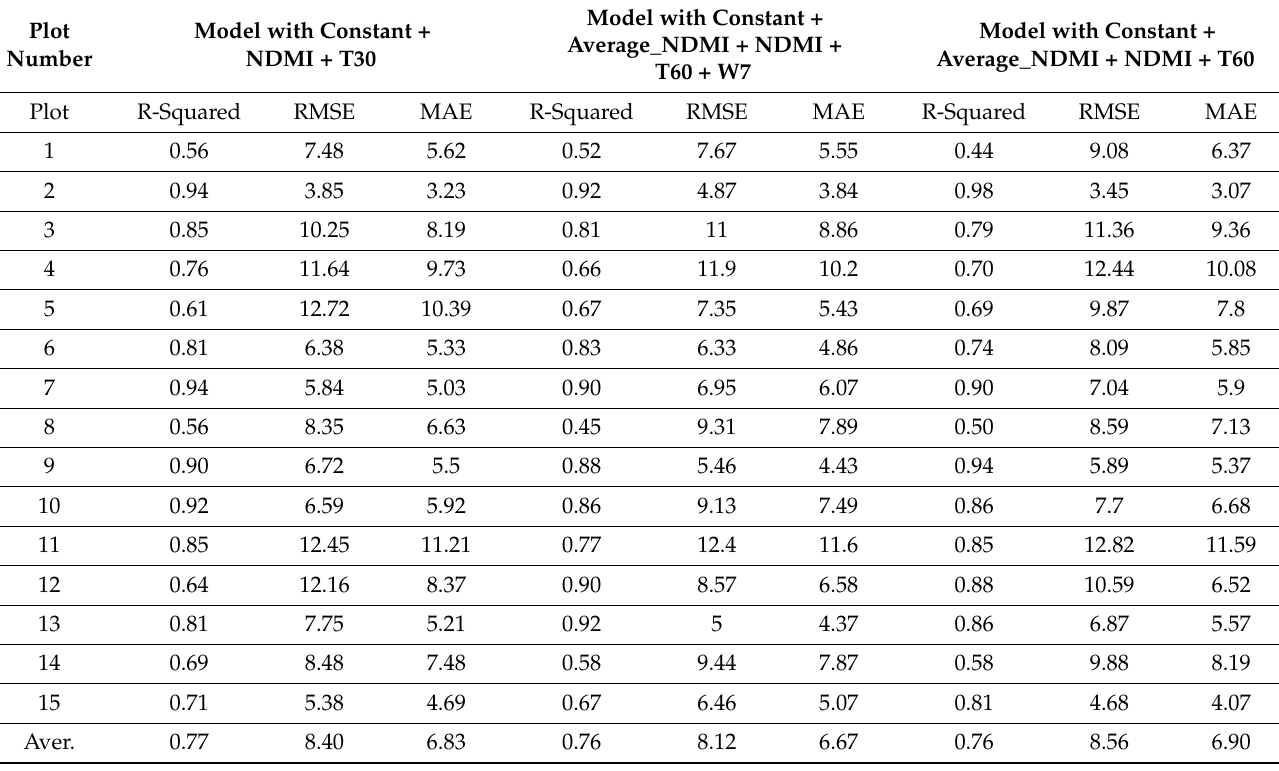
Table A1. RMSE and MAE obtained using leave-one-plot-out cross validation for three regression models. R-squared is the square of Pearson’s correlation coefficient between LFMC_WAS observations and cross validation predictions. The first model used NDMI + T30 as independent variables as in the MLR model of Table 5, the second model used Average_NDMI + NDMI + T60 + W7 as in the AdMLR model of Table 5, and the third model used Average_NDMI + NDMI + T60.